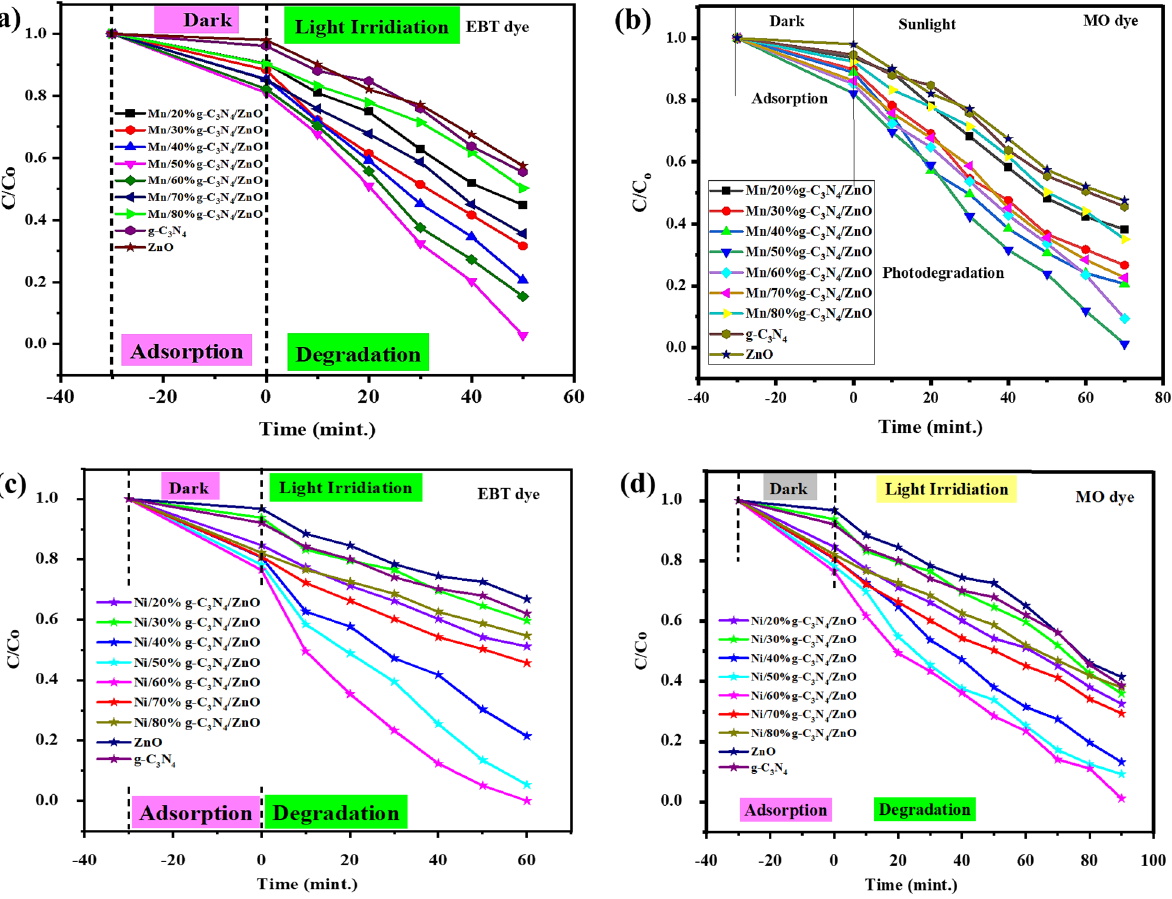
Figure 8. Photocatalytic decoloration rates of EBT ( a ) and MO dye ( b ) by Mn/50GZ NC, and decoloration rates of EBT ( c ) and MO dye ( d ) by Mn/50GZ NC.